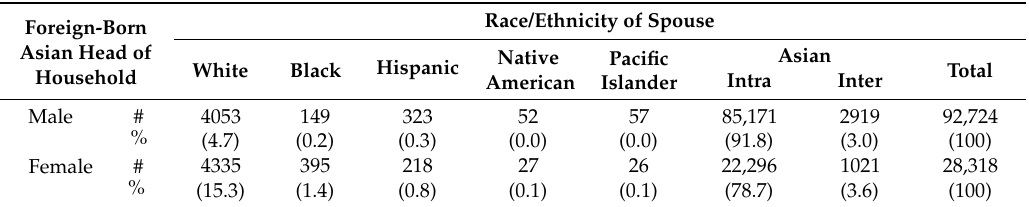
Table 4. Intermarriage Patterns of Foreign-Born Asian Household Heads by Race or Ethnicity of Spouses and by Sex, ACS